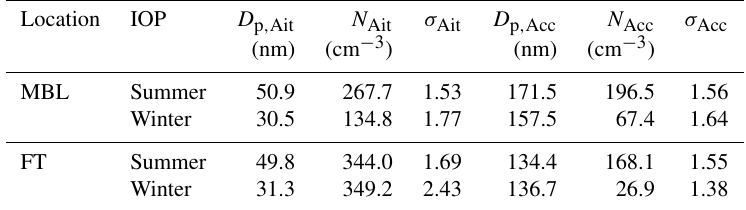
Table 2. The fitting parameters of average aerosol size distributions for the Aitken mode and accumulation mode during the summer IOP and winter IOP in the MBL and FT. The particle concentrations are normalized to standard temperature and pressure (273.15K and 101.325kPa; STP).